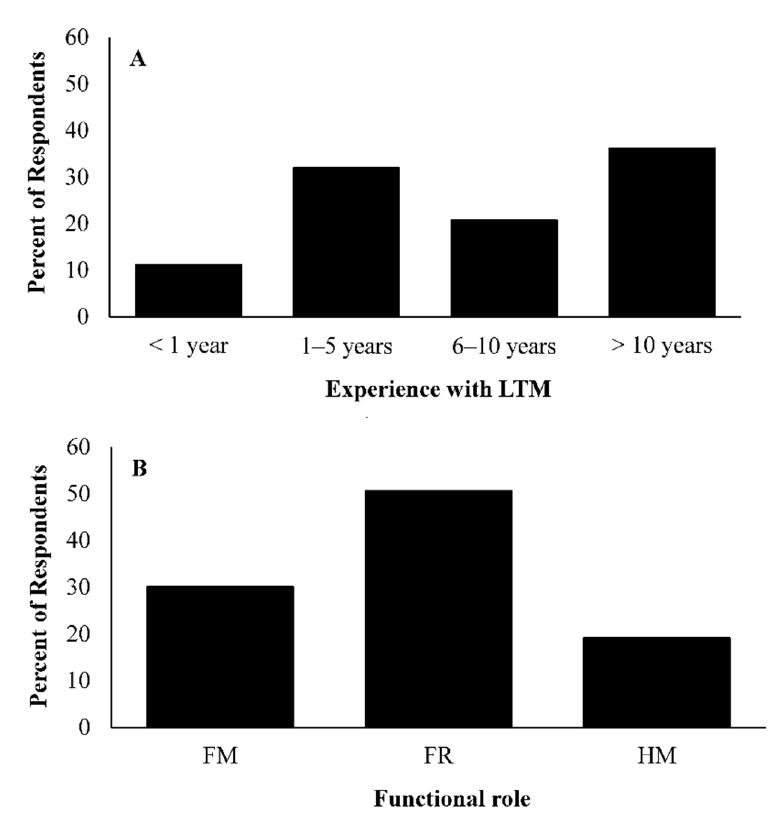
Figure 2. Demographics of respondents to an email survey about Florida’s statewide Freshwater Fisheries Long-Term Monitoring (LTM) program. Panels depict the percentage of respondents based on ( A ) experience with the LTM program and ( B ) functional role (fisheries management, FM; fisheries research, FR; and habitat management, HM).